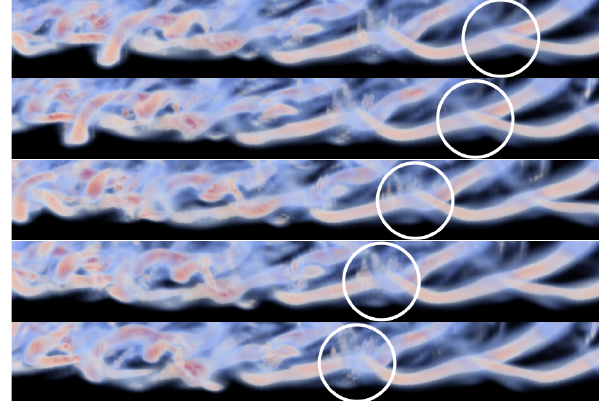
Figure 5. H-type VAWT with AR = 1 . 5: volume rendering of the vorticity magnitude (cid:107) ω (cid:107) ; vortex reconnections are visible on the side of the wake, here illustrated in the area behind the bottom left corner of the VAWT, at successive times. The turbine is on the right, and the velocity is directed to the